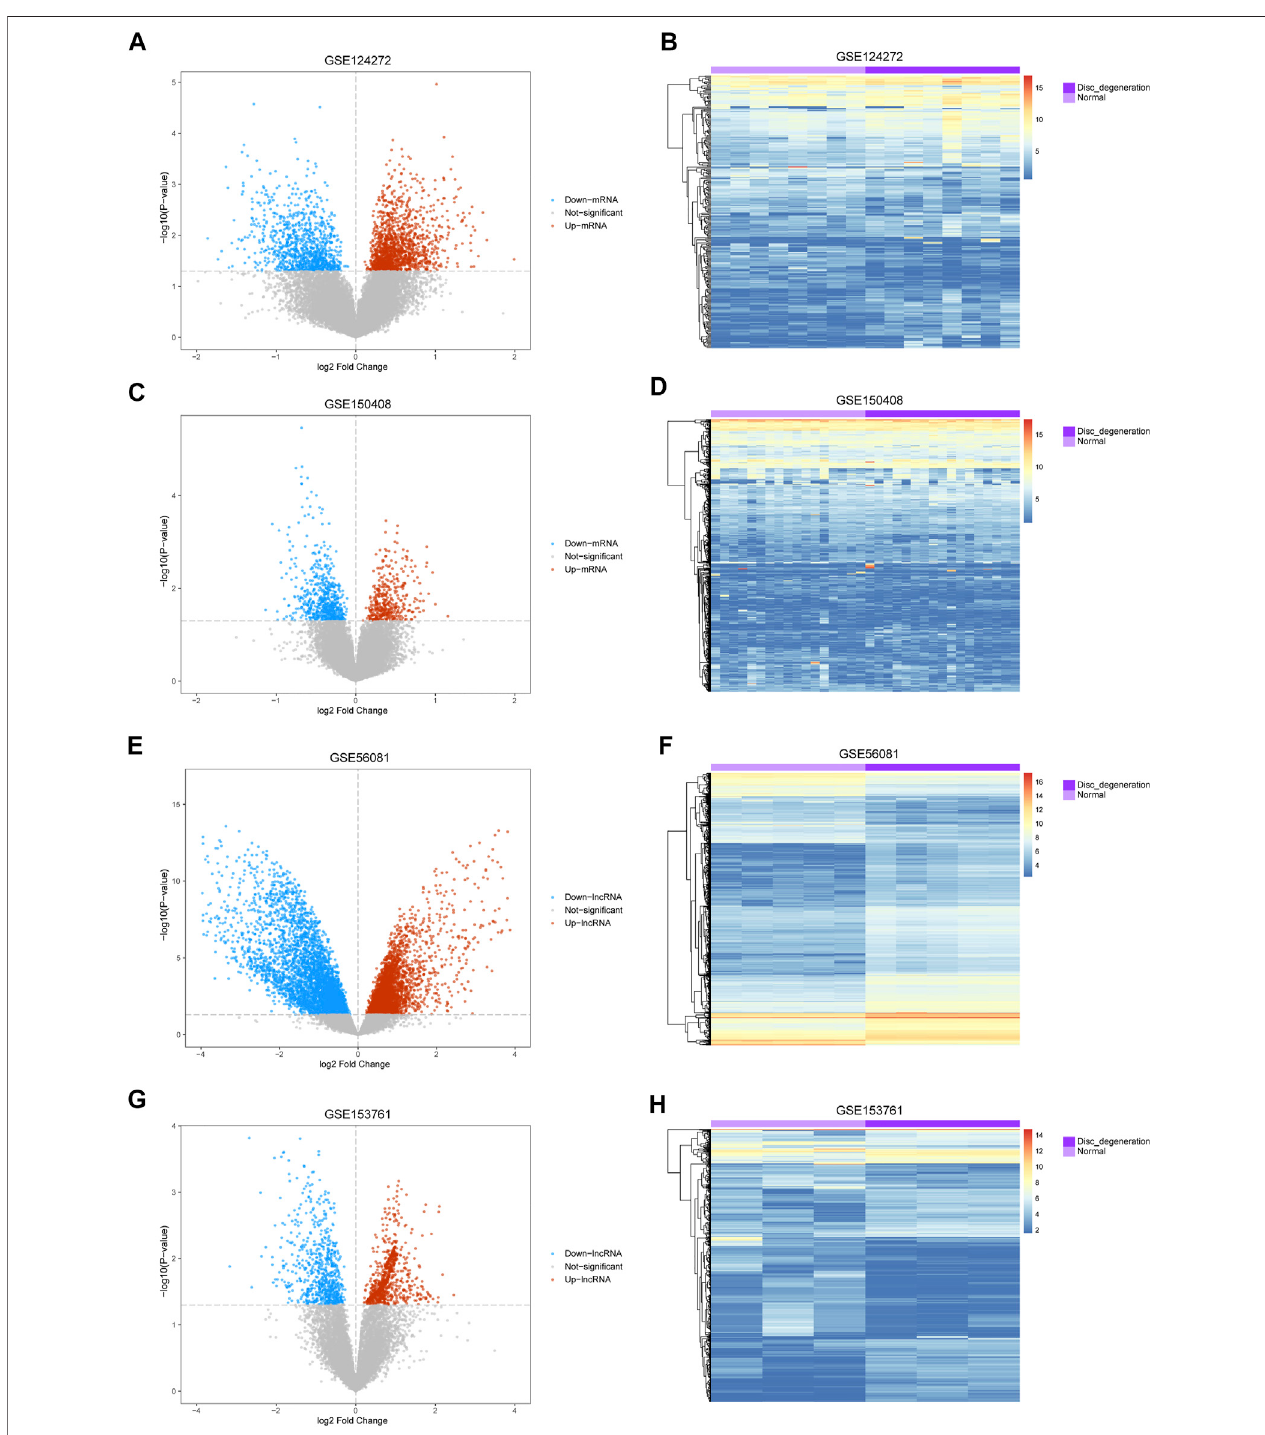
FIGURE 2 | Differential expression of mRNA and lncRNA associated with IDD. (A,C,E,G) Volcano map of differentially expressed genes. The abscissa represents thelog2-foldchange,andtheordinaterepresentsthe-log 10 ( p -value).Therednodeindicatestheupregulated differentiallyexpressed genes,thebluenodeindicatesthe downregulated differentially expressed genes, and the gray node indicates genes that are not signi fi cantly differentially expressed. (B,D,F,H) Heatmap of differentially expressed genes. The abscissa indicates the patient ID, and the ordinate indicates the respective differentially expressed genes. Red represents the high gene expression, and blue represents the low gene expression. The dark purple annotation bar represents the degenerative intervertebral disc tissue, and the light purple annotation bar represents the normal intervertebral disc